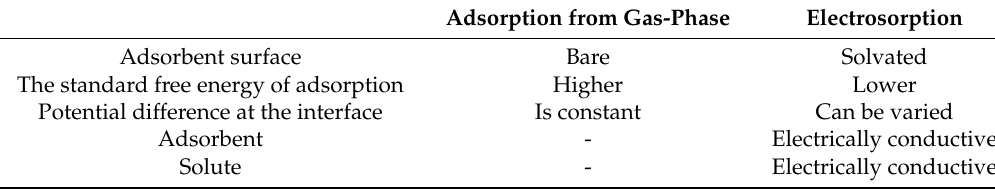
Figure 1. Schematic of the electrosorption process. Table 2. Differences between gas-phase adsorption and electrosorption.